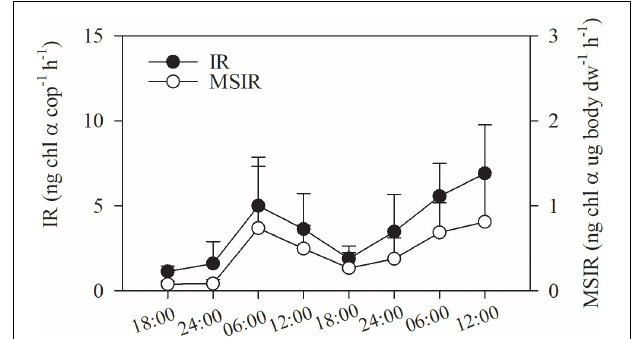
Kolmogorov–Smirnov and Mann-Whitney tests showed the same grouping result except that feeding selection of copepod on diatoms was comparable to the cases of prymnesiophytes and chlorophytes ( p = 0.161 and 0.083, Table 4